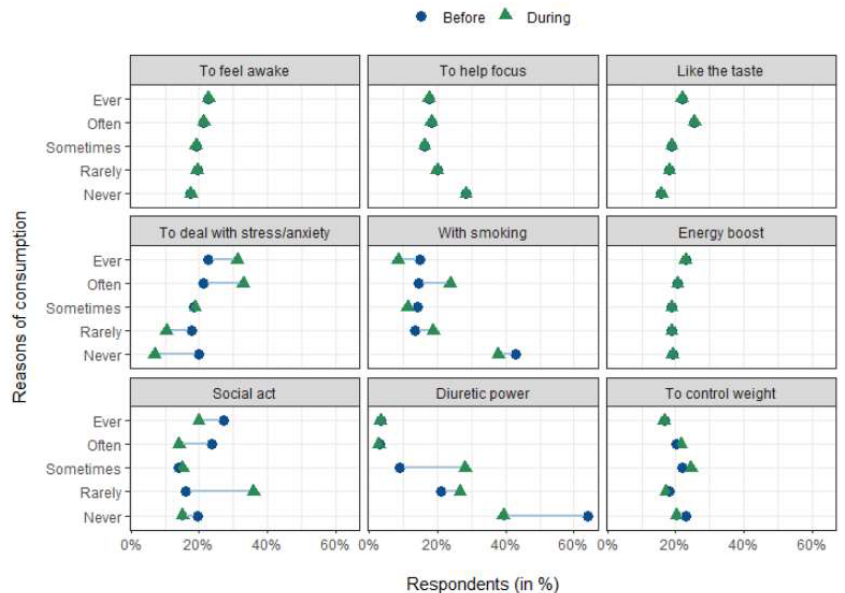
Figure 2. Reasons for coffee consumption considering before and during the COVID-19 pandemic mandatory confinement in a continous perspective.